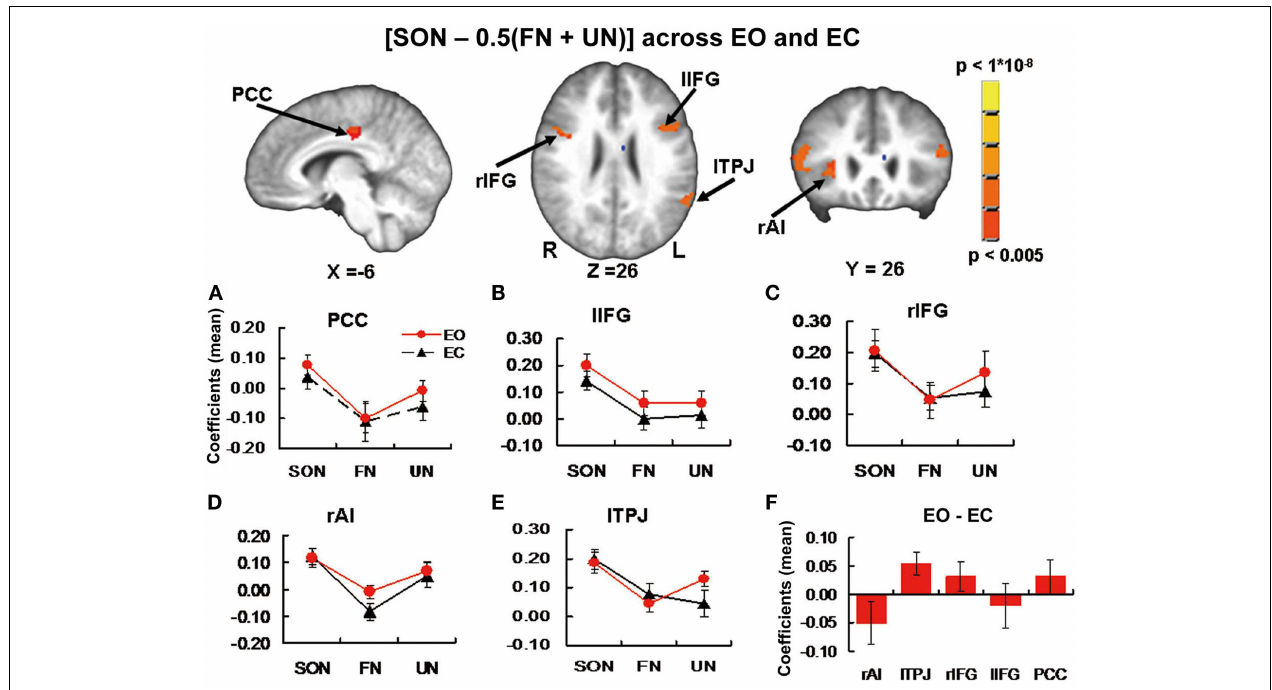
activity between baselines. (F) From Experiment 2. Estimated coefficients (mean across region ± SE) for the contrast [EO – EC] in the same ROI’s. Again no significant differences were found. PCC, posterior cingulate cortex; r/lIFG, right/left inferior frontal gyrus; rAI, right anterior insula; lTPJ, left temporoparietal